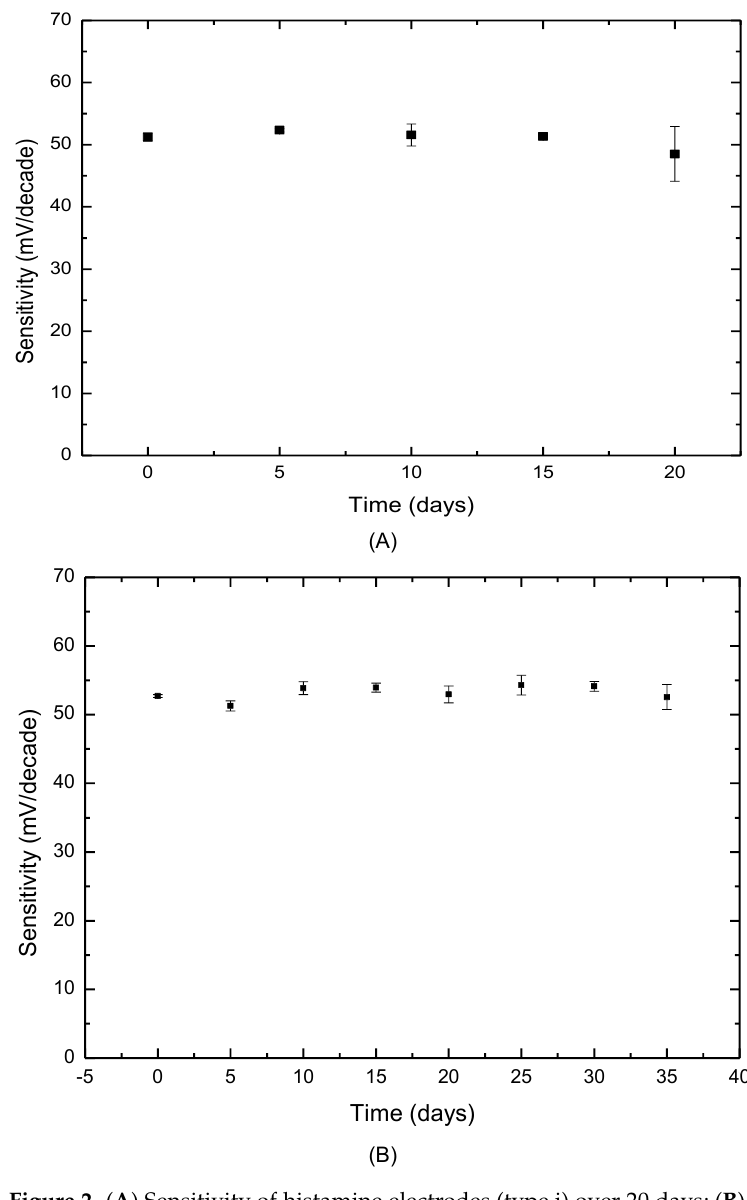
Figure 2. ( A ) Sensitivity of histamine electrodes (type i) over 20 days; ( B ) Sensitivity of histamine electrodes (type ii) over 35